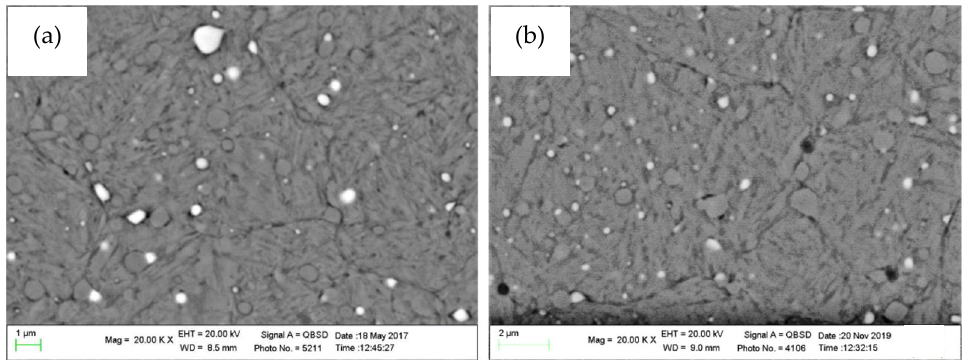
Figure 4. SEM-BSE representative micrographs of sample treated according to K890-I ( a ) and K890-II ( b ).